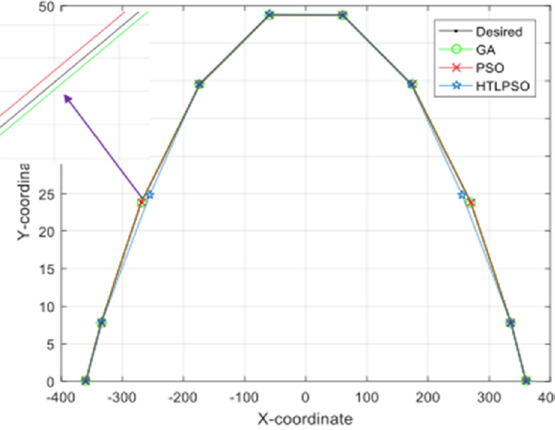
Figure 5: Hip trajectory comparisons during the stance